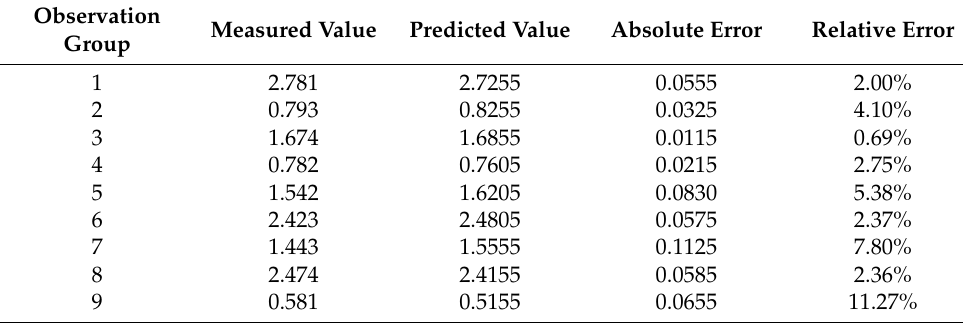
Table 10. Surface roughness predictive